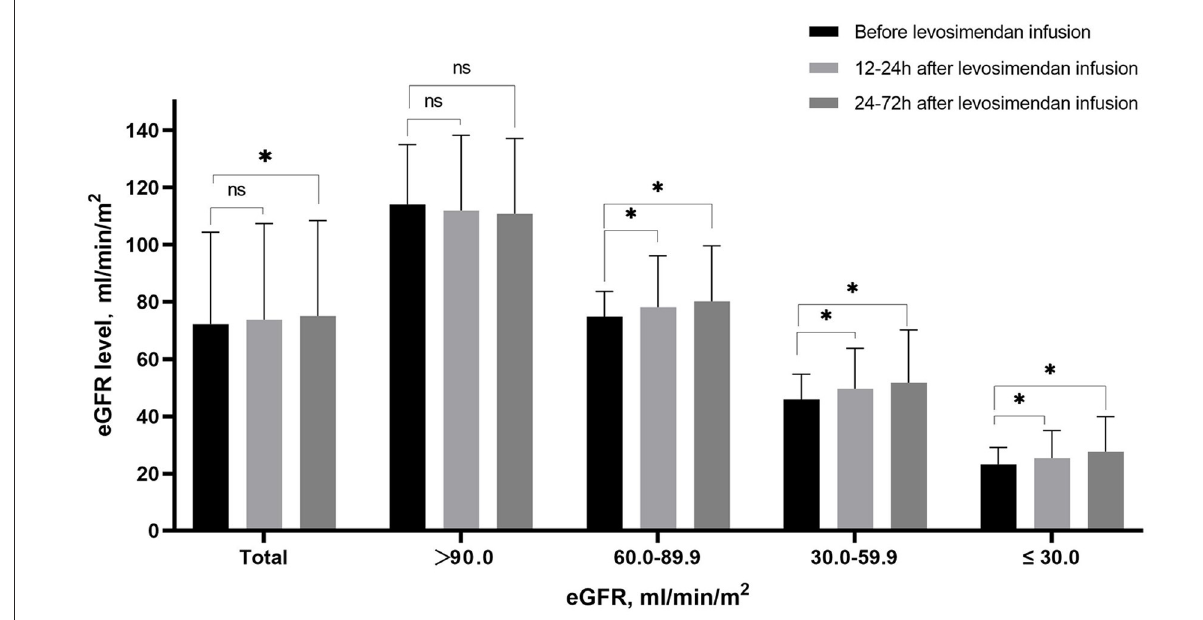
FIGURE4 Mean eGFR before levosimendan infusion, at 12–24h and 24–72h after levosimendan infusion according to baseline eGFR level. * Statistically significant difference compared with eGFR level before levosimendan infusion ( p < 0.05). ns Non-statistically significant difference compared with eGFR level before levosimendan infusion ( p >